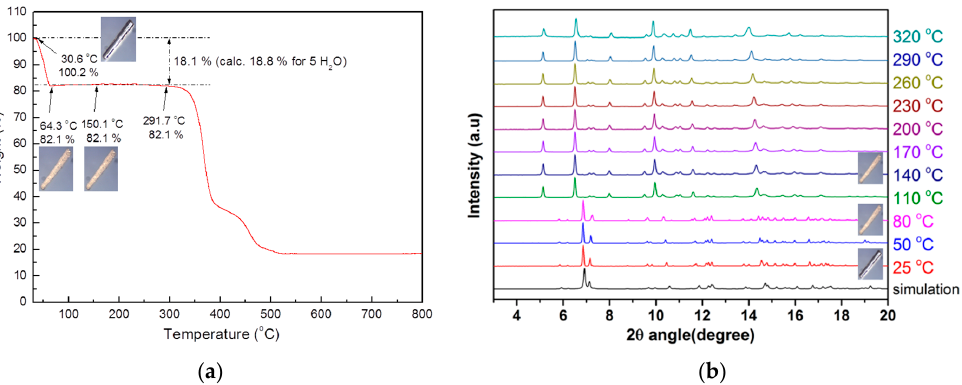
Figure 4. ( a ) Thermogravimetric (TG) analysis of 2 associated with morphological changes at selected temperatures. ( b ) Powder X-ray diffraction patterns at RT and selected temperatures and its simulation from single-crystal diffraction data associated with morphological changes at selected temperatures of 2 . The baselines for each temperature were shifted for clarity.